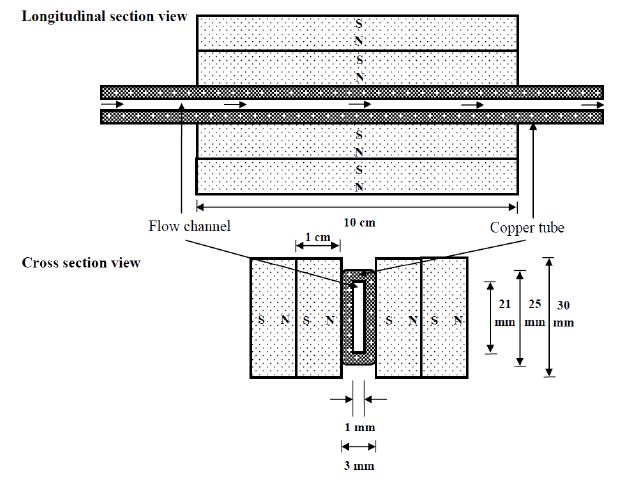
Fig. 1. Magnetic treatment device; N-North pole, S-South pole Tab. 1. Estimated parameters for the response curves of jimsonweed treated with glyphosate or imazethapyr applied with the different carriers alone or in the presence of water